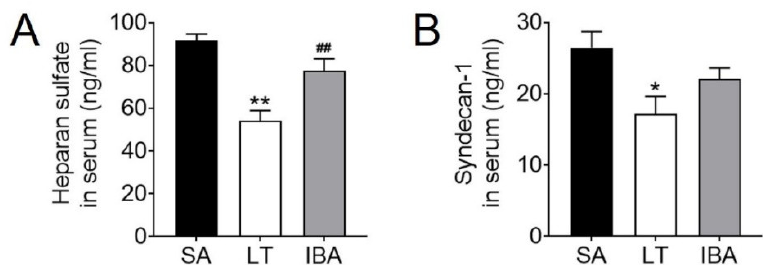
Figure 9. Serum endothelial permeability marker levels in ground squirrels. ( A ) Serum levels of HS.